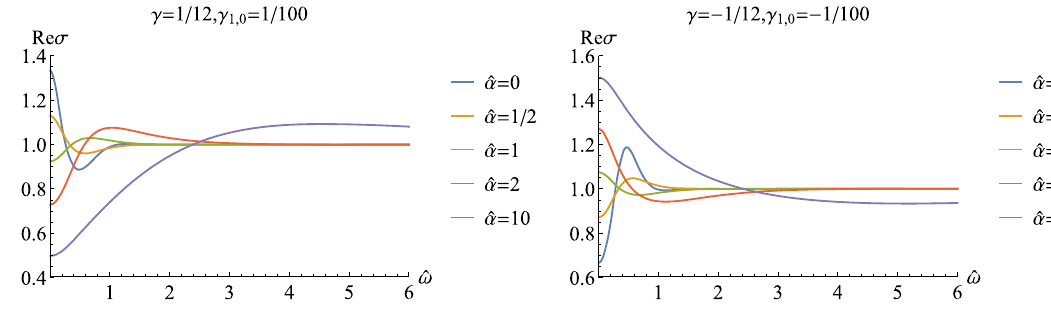
Fig. 9 The optical conductivity σ( ˆ ω) as a function of ˆ ω with representative γ 1 , 0 , γ and ˆ α